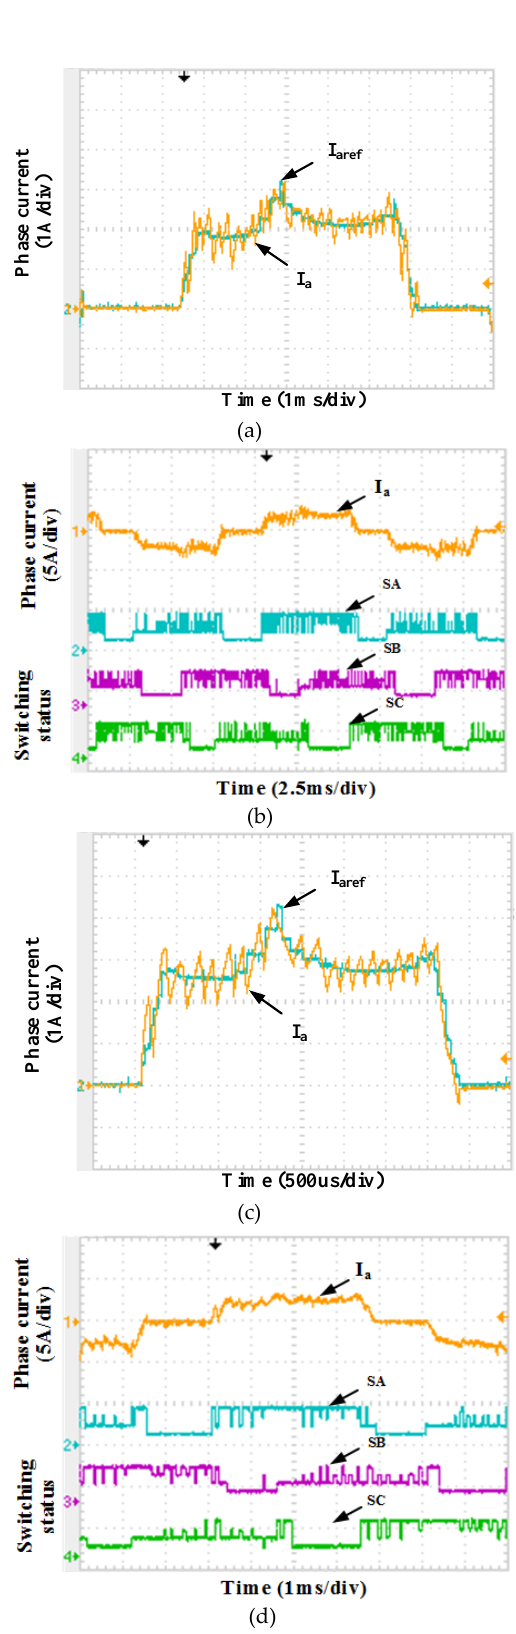
Figure 13. Experimental results of the drive in speed of 500 and 750 rpm: ( a ) phase current in phase-change angle α of 6.5 ◦ ; ( b ) switching status in phase-change angle α of 6.5 ◦ ; ( c ) phase current in phase-change angle α of 20 ◦ ; ( d ) switching status in phase-change angle α of 20 ◦